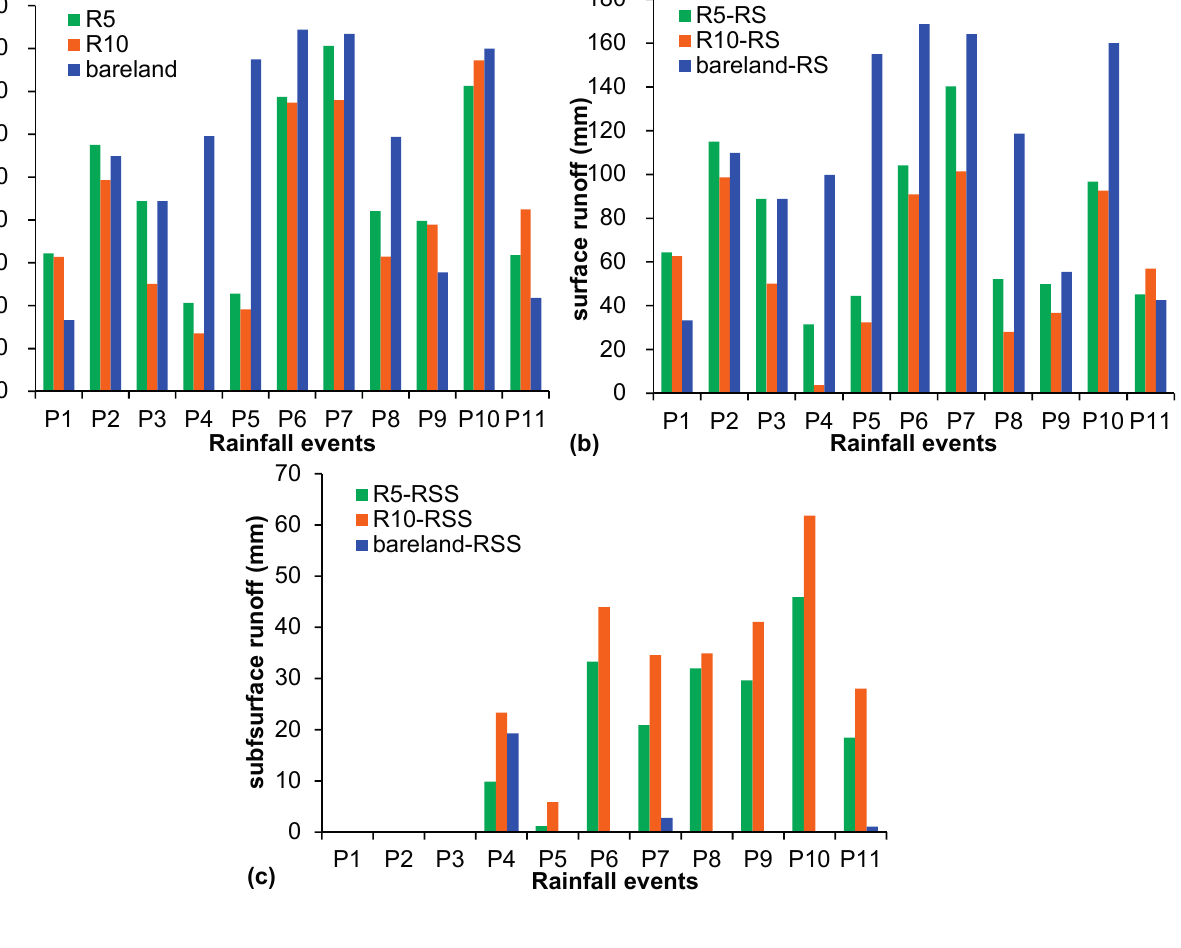
Figure 2. Runoff amount of the three plots in 11 rainfall events: ( a ) total runoff, ( b ) surface runoff (referred to as RS) and ( c ) subsurface runoff (referred to as RSS).